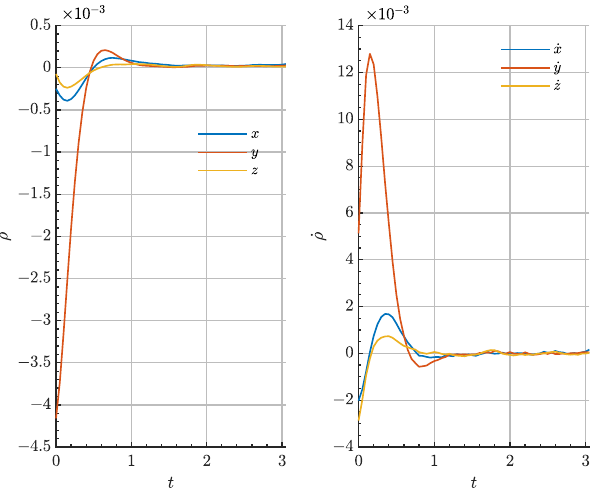
Figure 12. Evolution of the relative state vector components for the JWST servicing spacecraft during the long-range homing.